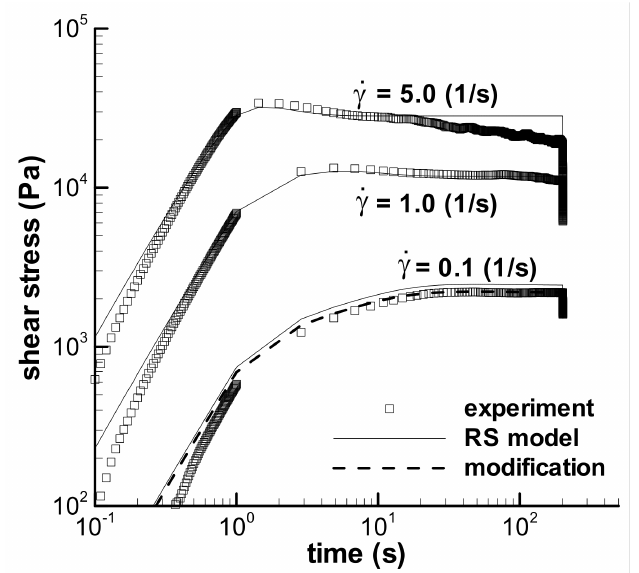
Figure 10. Predictions of the trapezoidal-loop experiments with the maximum shear rates of 0.1 s − 1 , 1 s − 1 and 5 s − 1 , t 0 = 1 s and t 1 = 200 s. Solid line is the calculation by the RS model, and dashed line is the modification with f = 0.875 in Table